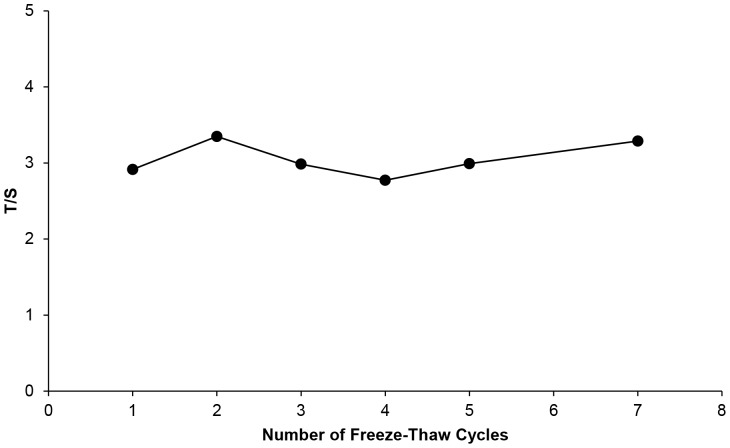
The effect of repeated freezing and thawing on T/S ratio measurements.DNA was extracted from whole blood aliquots obtained at each of seven consecutive freeze-thaw cycles and T/S ratios were determined.